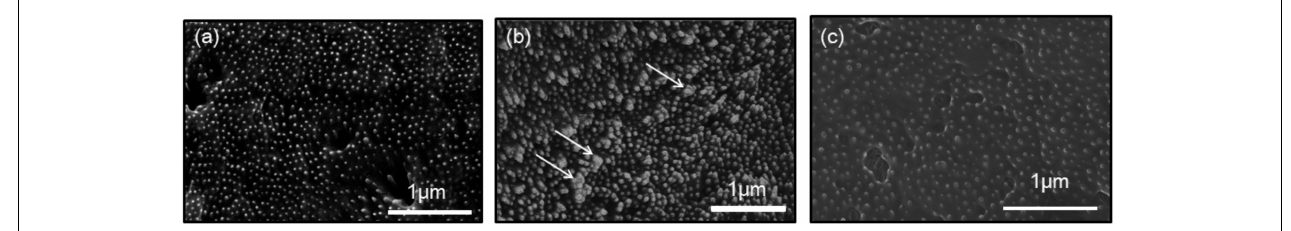
FIGURE 2 | Scanning electron microscopy (SEM) observations of the surface of the growing edge of the ligament in the samples injected with dsRNA targeting (a) enhanced green fluorescence protein (EGFP), (b) MMP07860, and (c) MMP14973. The injection of EGFP and MMP14073 showed normal surface, while the injection of MMP07860 showed small aggregation of aragonite crystals. White arrows indicate the aggregation of aragonite crystals.